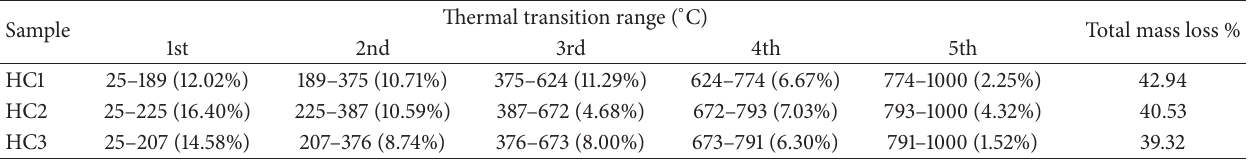
Table 4: Thermogravimetric analysis